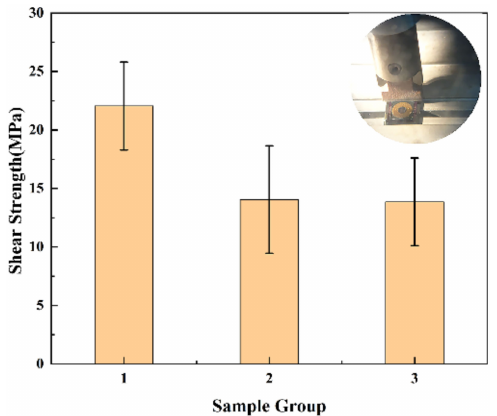
Figure 13. Bonding strength of the Cu–Sn bonding, Au–Au bonding, and dual bonding.